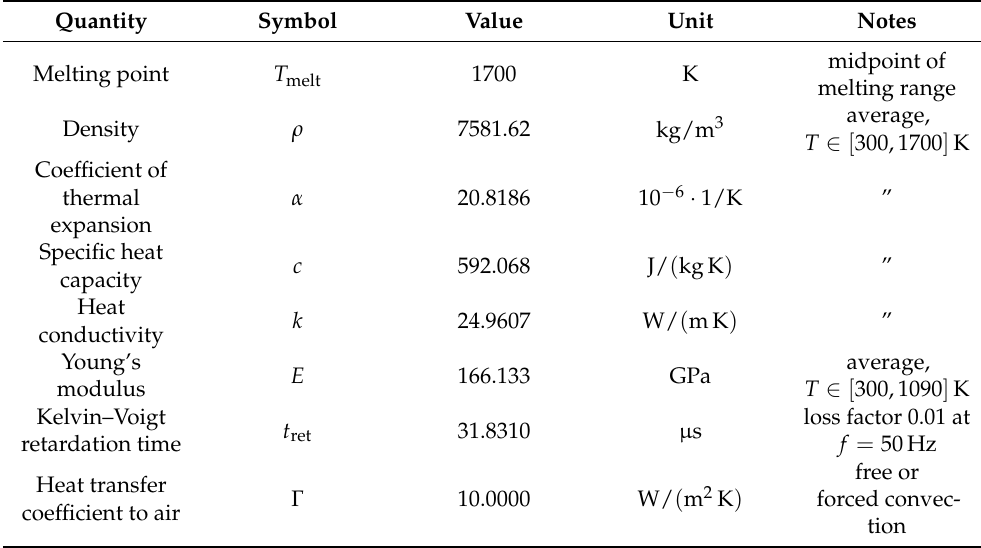
Table 1. Material parameters of 316L steel, used in the numerical